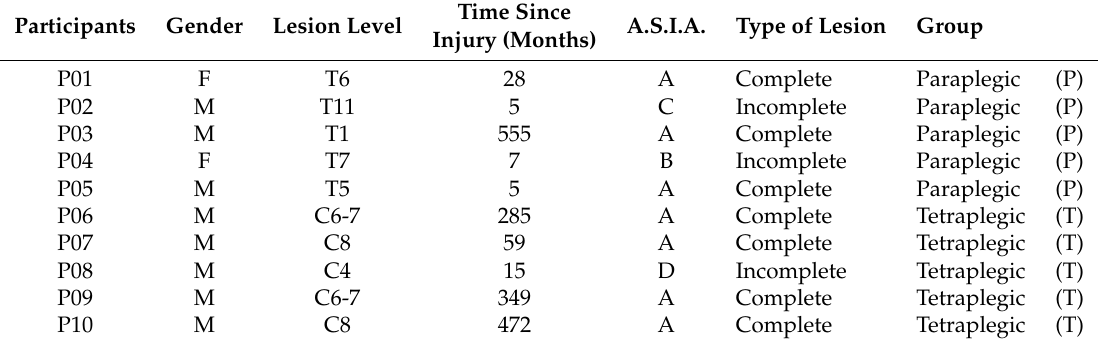
Table 3. Participants lesion